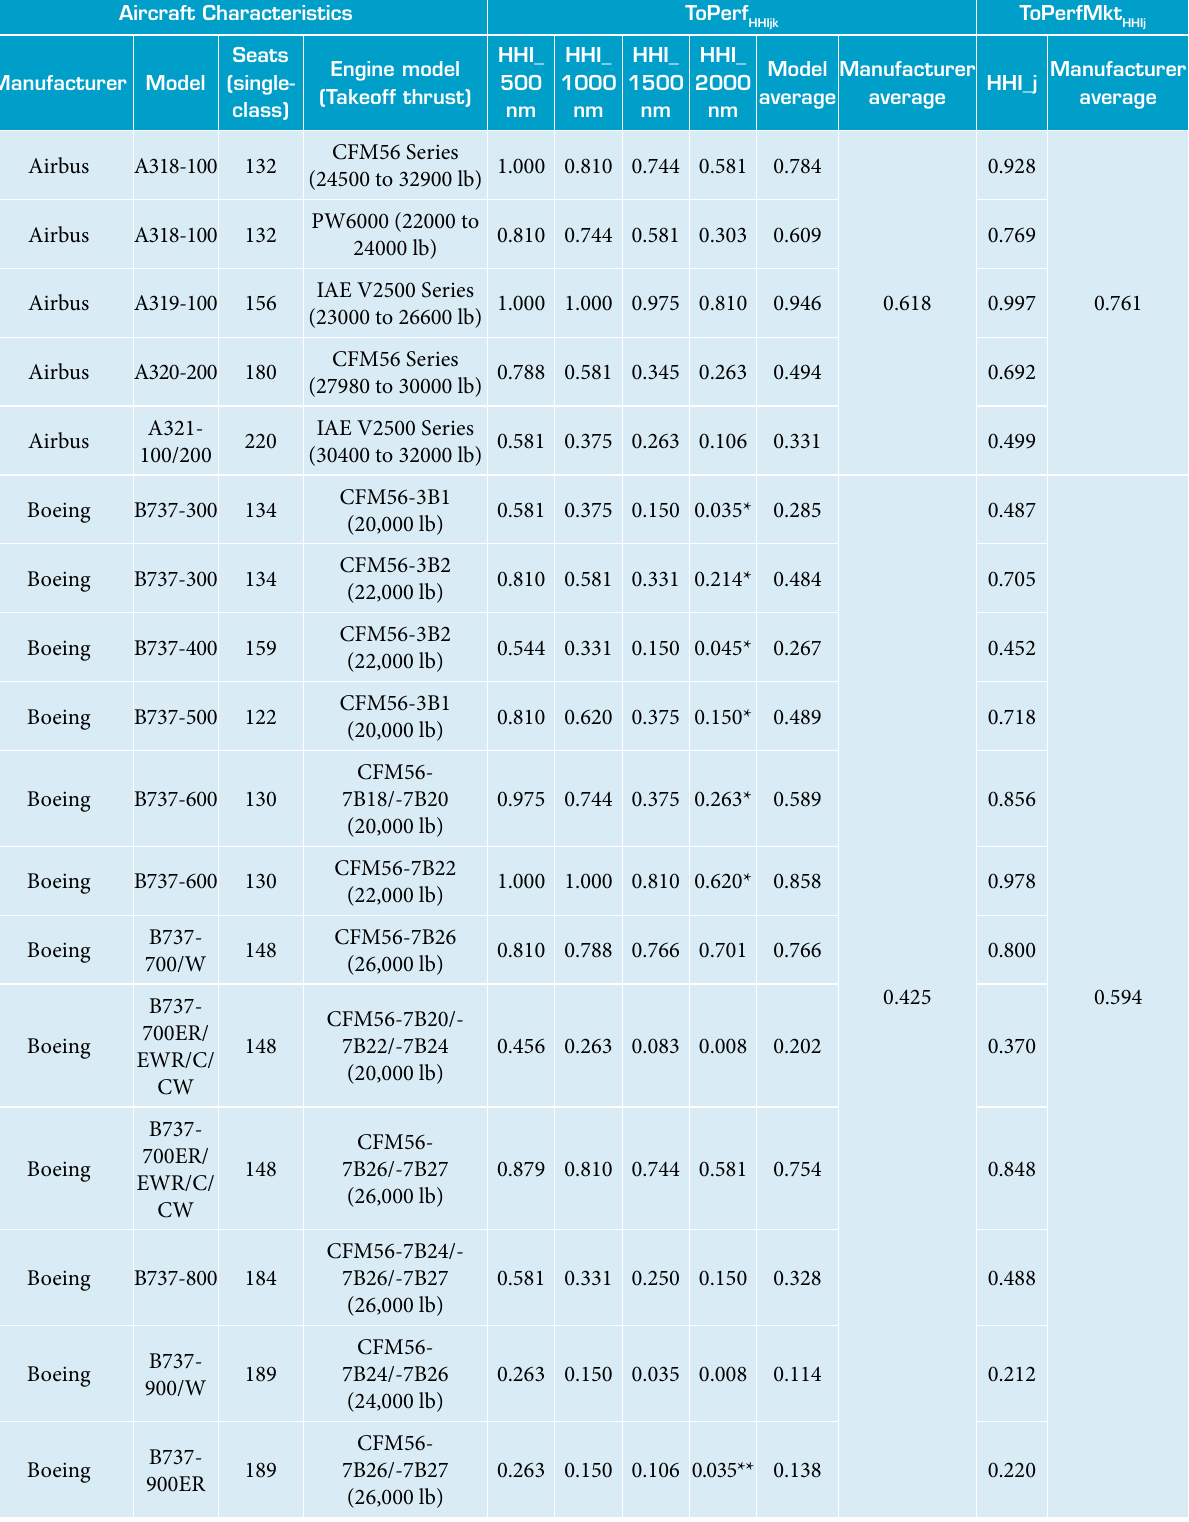
Table 4. Aircraft take-off HHI